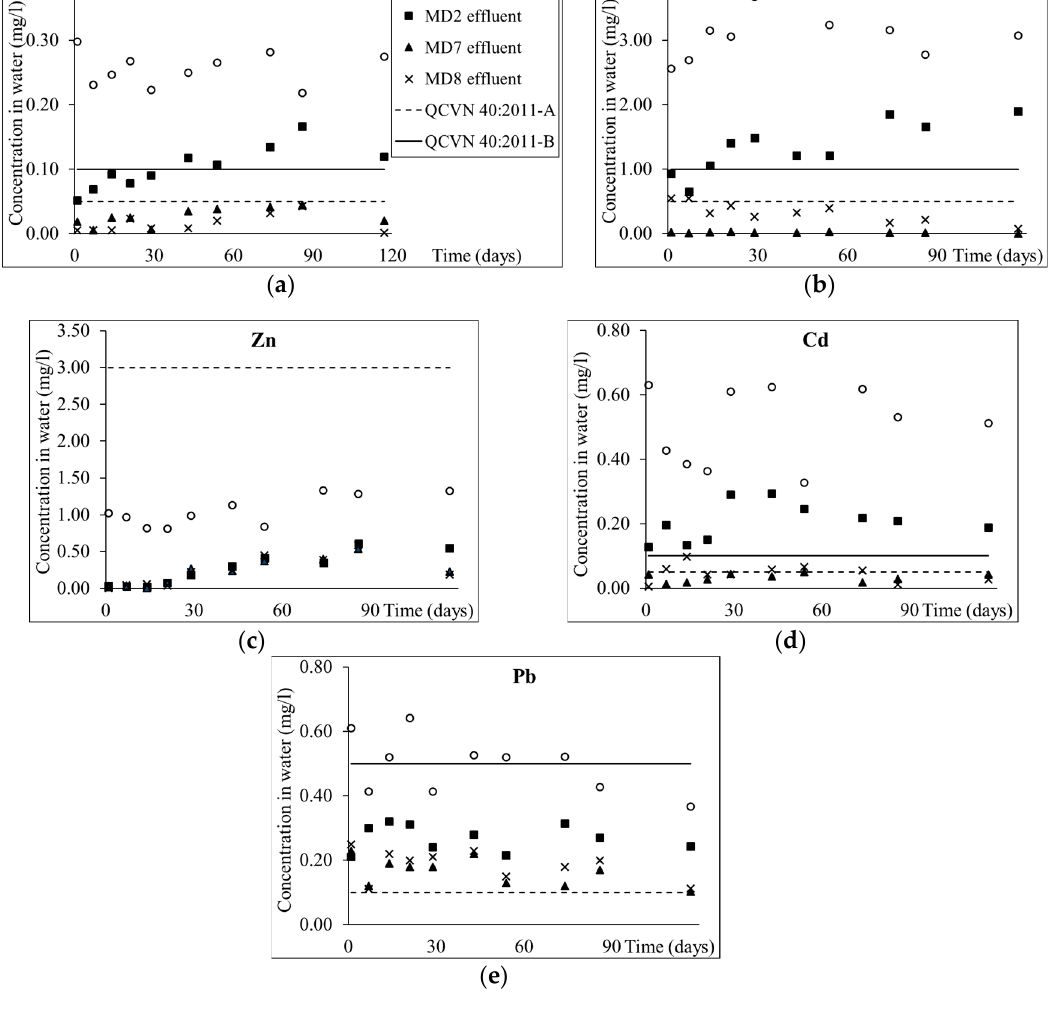
Figure 2. Concentrations of ( a ) As, ( b ) Mn, ( c ) Zn, ( d ) Cd, and ( e ) Pb in wastewater before entering the treatment system (Ci) and in the effluents from the adsorbent tank (MD2), constructed wetland with limestone substrate (MD3 ‐ MD7), and constructed wetland with laterite substrate (MD8).